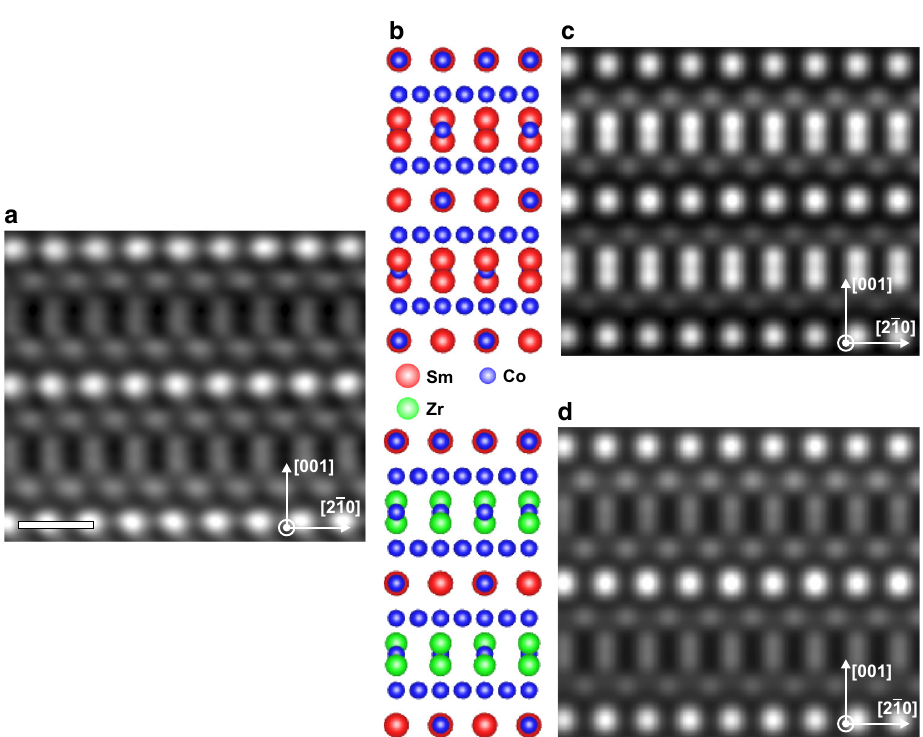
Fig. 2 Atomic-resolution HAADF-STEM images of the Z-phase. a Experimental ( left ), b atomic models ( center ) and simulated ( right ) atomic resolution STEM-HAADF Z -contrast images for c SmCo 3 and d Zr 2 SmCo 9 . All images are viewed along the [120] zone axis. The experimental image was fi ltered by principal component analysis to reduce the effect of noise. Scale bar, 5